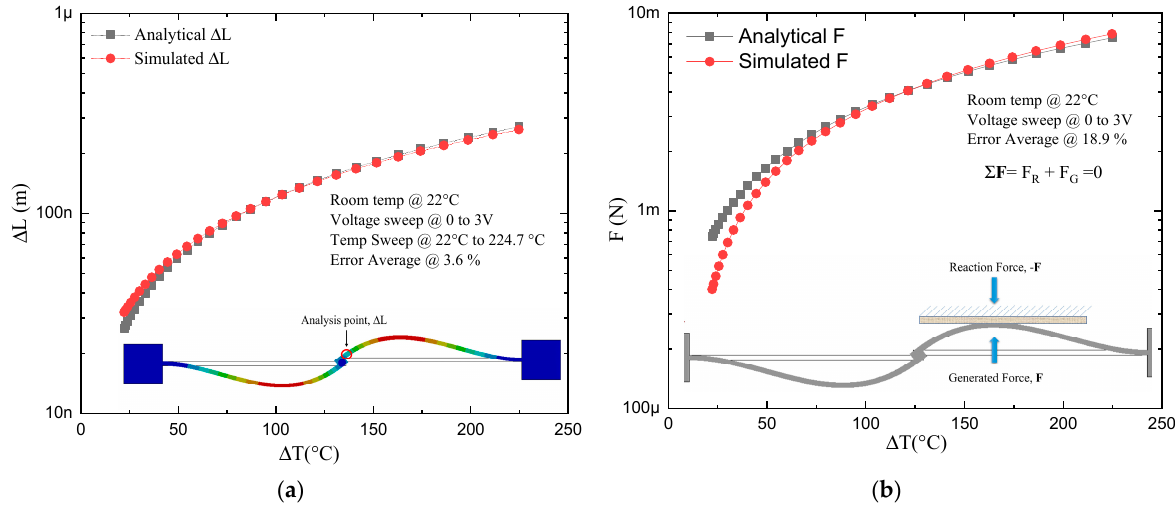
Figure 6. Thermoelectric results of microactuator with two beams. ( a ) Displacement at the middle point. ( b ) Reaction force. point. ( b ) Reaction